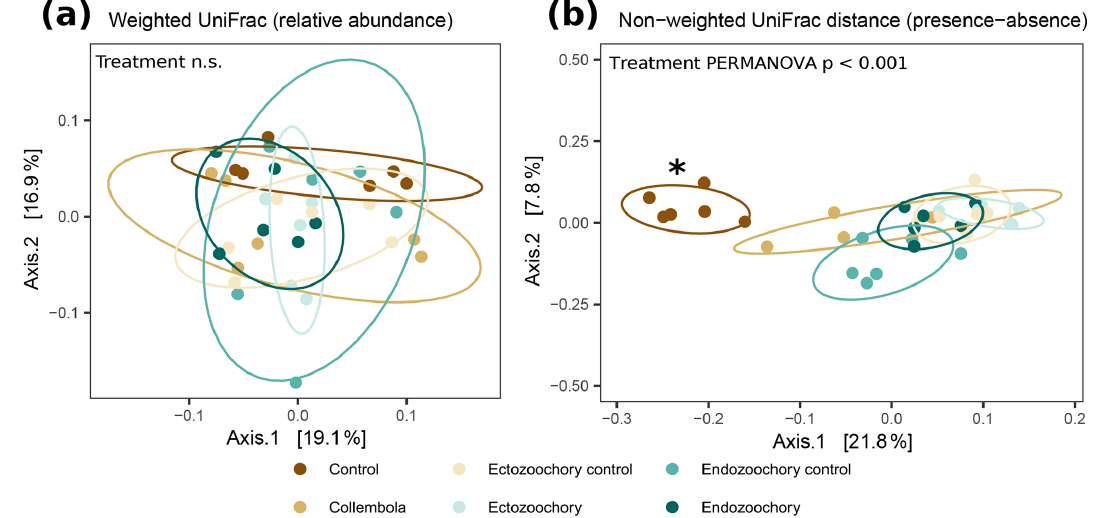
Figure 2. Response of permafrost bacterial communities to the addition of Collembola undergoing different microbiome manipulation treatments. (a) Principal coordinates analysis (PCoA) of normalized abundance of bacterial ASVs (amplicon sequence variants) based on weighted UniFrac phylogenetic distance (i.e. accounting for relative abundances); (b) PCoA of normalized abundance of bacterial ASVs based on non-weighted UniFrac phylogenetic distance (i.e. presence–absence only). Ellipses indicate the 80% confidence interval around treatment centroids, and axes are scaled to the percentage of explained variance. The asterisk indicates that the no-Collembola control (dark brown) in (b) significantly differs from all other treatments (pairwise PERMANOVA P < 0.05) and endo- and ectozoochory treatments did not differ from the Collembola treatment. Pairwise comparisons are summarized in Table C1.